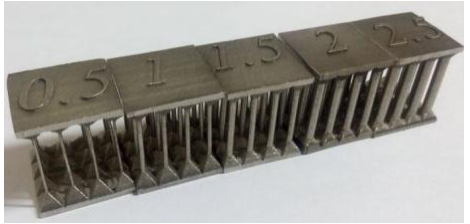
Figure 4. Compression test samples with different parameters.